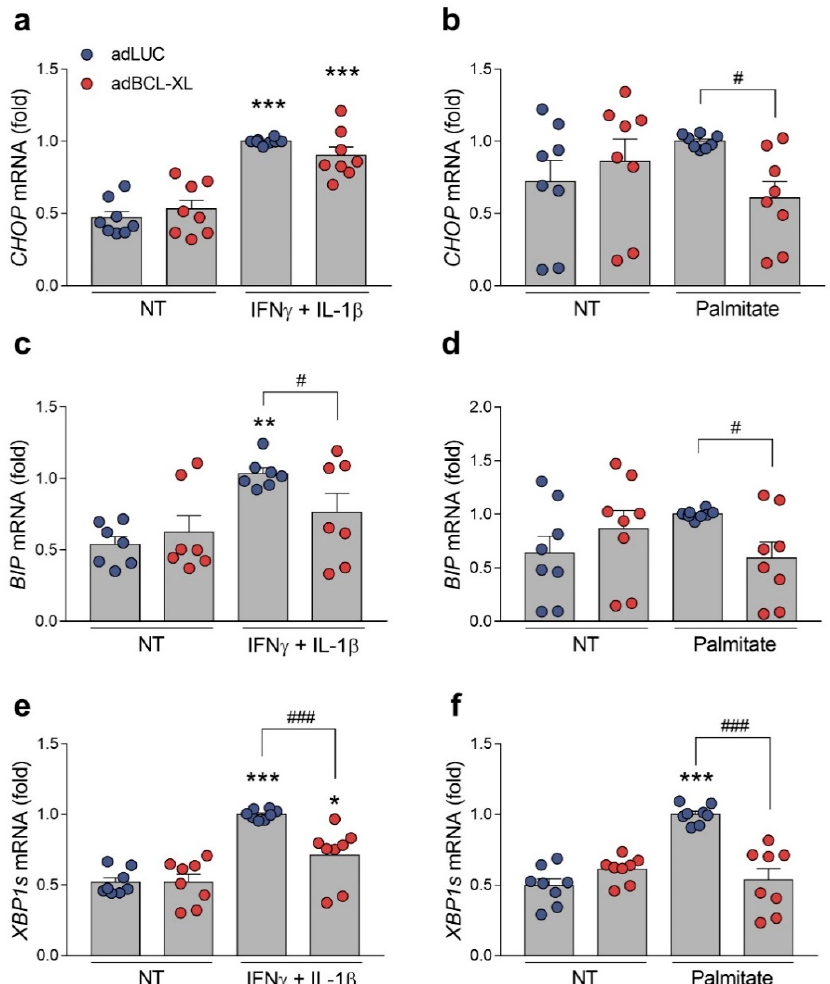
Figure 7. BCL-XL overexpression alleviates ER stress upon inflammatory or metabolic insults in human β -cells. EndoC- β H1 cells were infected with adenoviral (ad) vectors encoding luciferase (adLUC, blue dots) or rat BCL-XL (adBCL-XL, red dots). After 48 h of recovery, cells were left untreated (NT) or treated with either IFN γ + IL-1 β (50 and 1000 U/mL, respectively) ( a , c , e ) or 0.5 mM palmitate ( b , d , f ) for 48 h. The mRNA expressions of CHOP ( a , b ), BIP ( c , d ), and XBP1s ( e , f ) were analyzed by RT-qPCR and normalized by β -actin. Results are the means ± SEM of the 7 to 8 independent experiments. * p ≤ 0.05, ** p ≤ 0.01, and *** p ≤ 0.001 vs. untreated (NT) and infected with the same adenoviral vector; # p ≤ 0.05 and ### p ≤ 0.001, as indicated by bars. Two-way ANOVA.